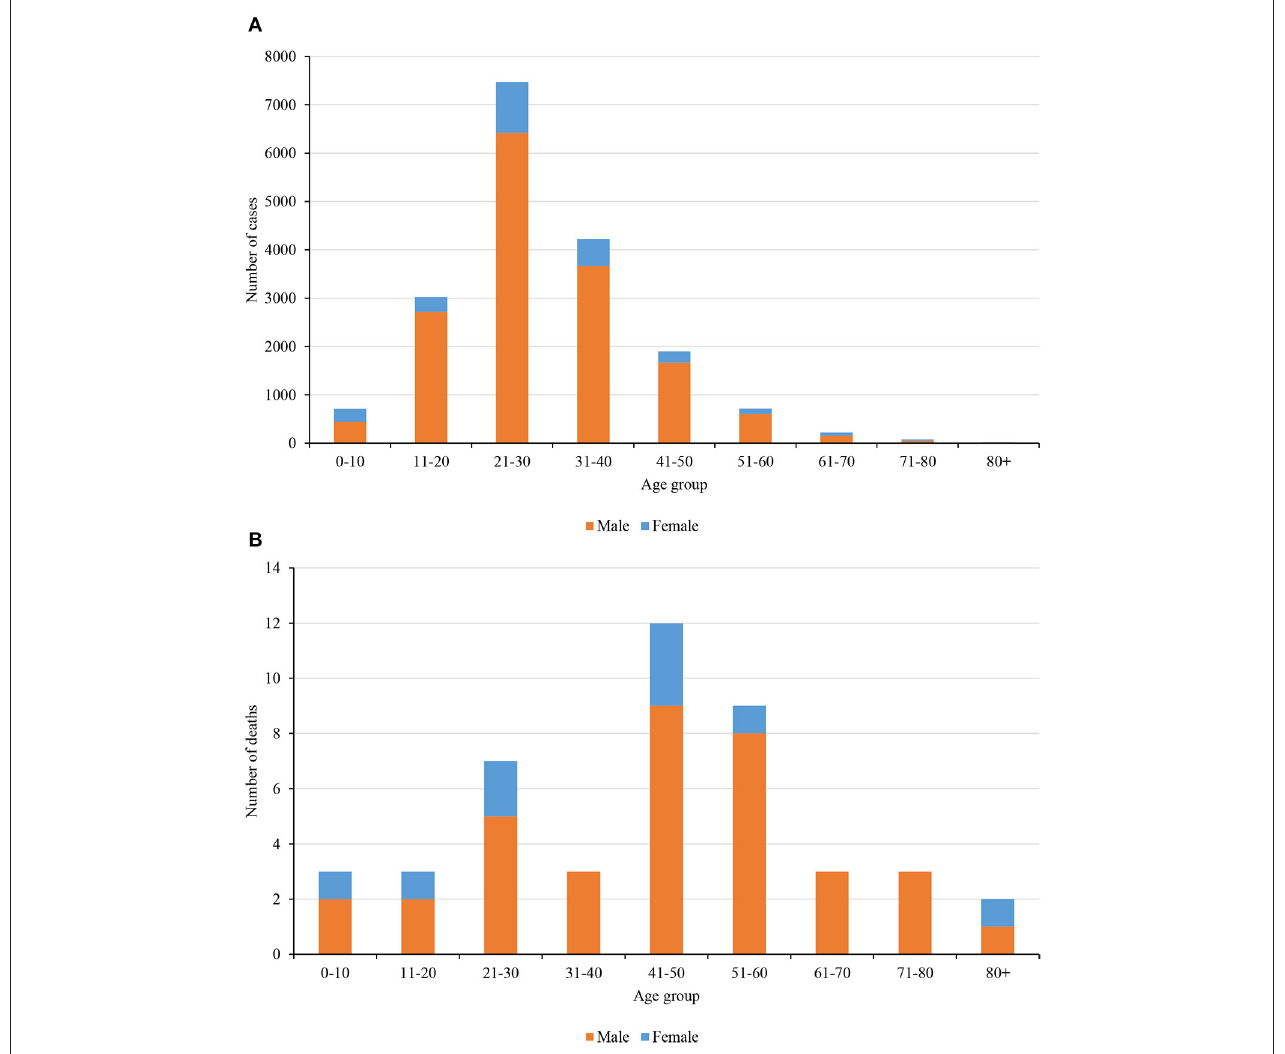
FIGURE 3 | (A) COVID-19 cases distribution among age and gender groups during the lockdown period. (B) . COVID-19 deaths distribution among age and gender groups during the lockdown period.